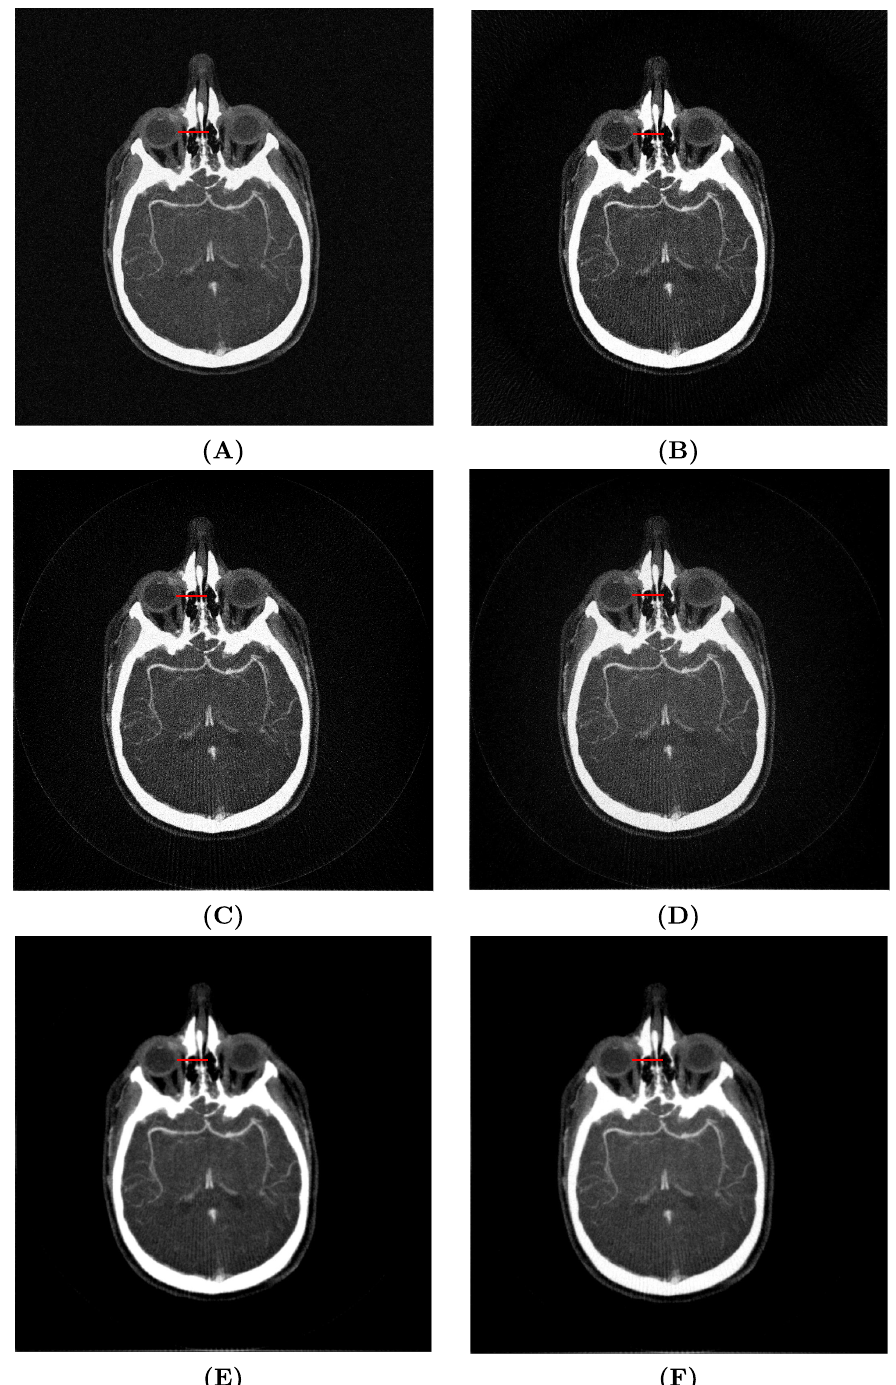
Fig 8. Visual comparison using 180 projections. (A) original image with Gaussian noise; (B) FBP; (C) BPF; (D) BPF-W; (E) BPWD; (F) BPWD-W.